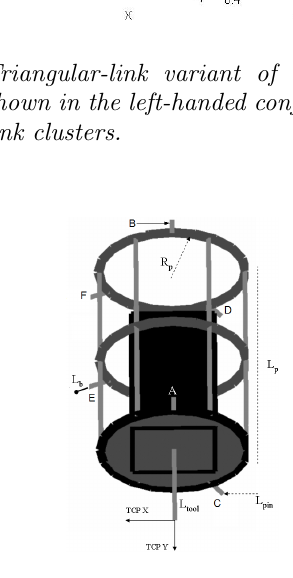
Figure 3: The manipulated platform of the Gantry-Tau robot.